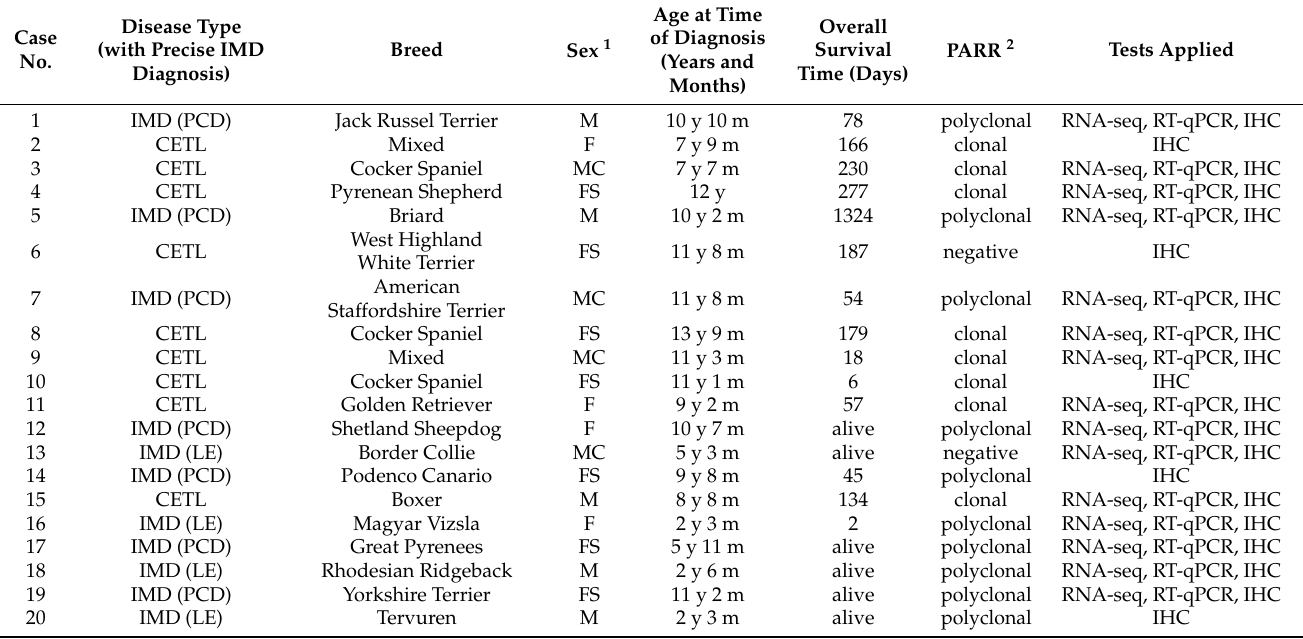
Table 2. Signalment, overall survival and PARR results of the study